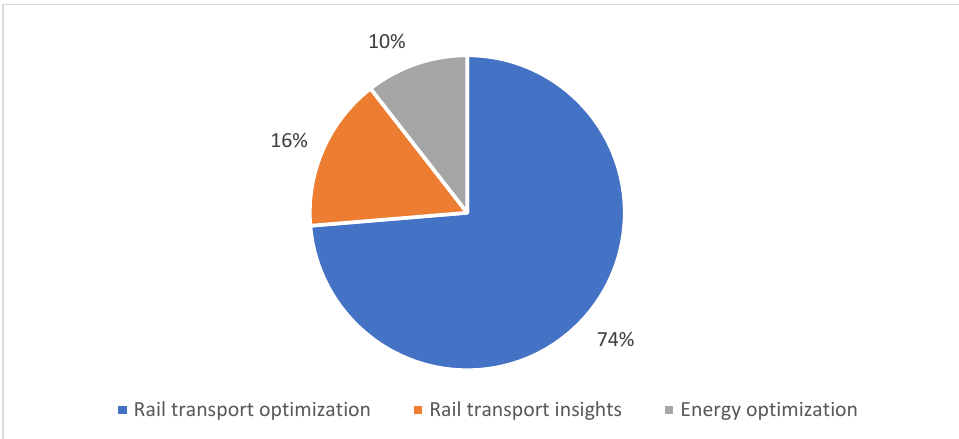
Figure 9. Distribution of the selected papers by decision and planification techniques domain.